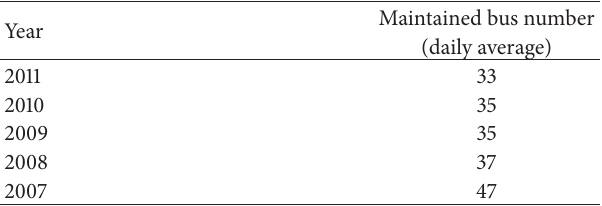
Table 2: Maintained bus number per